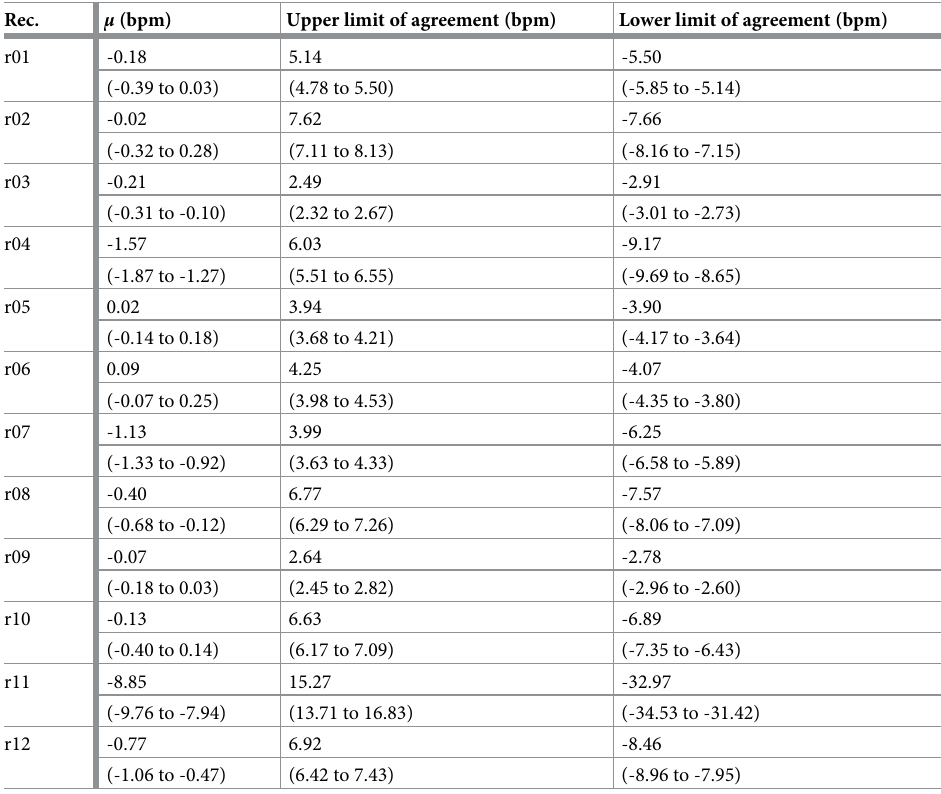
Table 4. Mean values μ and values of limits of agreement determined by the ICA-RLS-EEMD method for record- ings from the FECGDARHA database (the 95% confidence interval is reported in parenthesis). Rec.